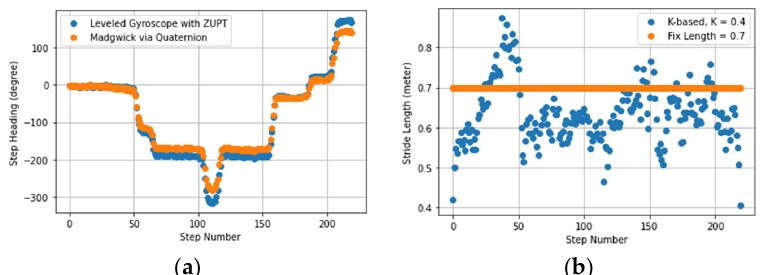
Figure 2. Realization of PDR elements reproducing available benchmarks, listed as: ( a ) Step heading calculation using Madgwick fusion of IMU and leveled Gyroscope considering ZUPT; and ( b ) K-based stride length estimation.